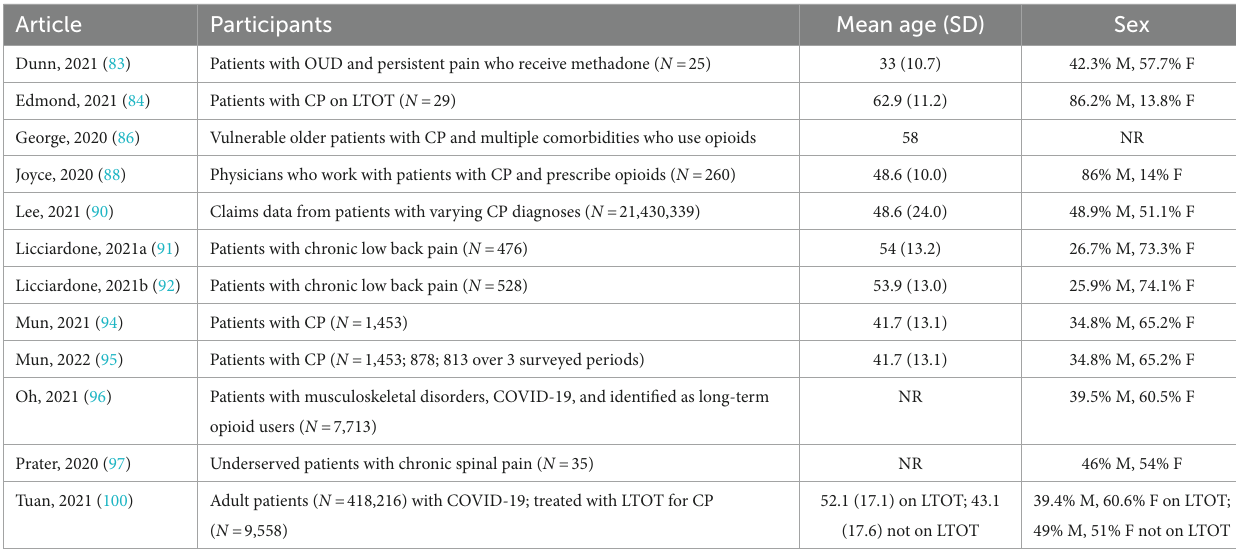
TABLE 3 Participant characteristics of included original research